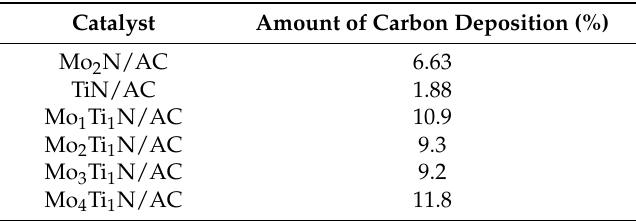
Table 4. The carbon depositions of the three